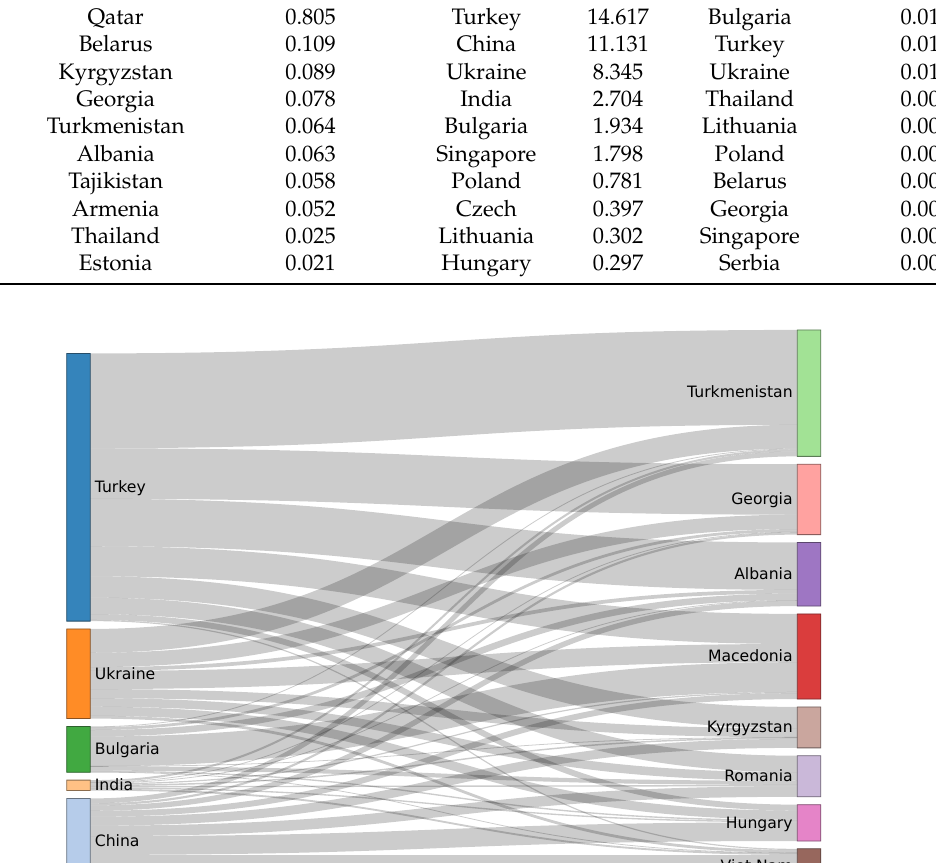
Figure 4. Main EGSR flow relationships at the country